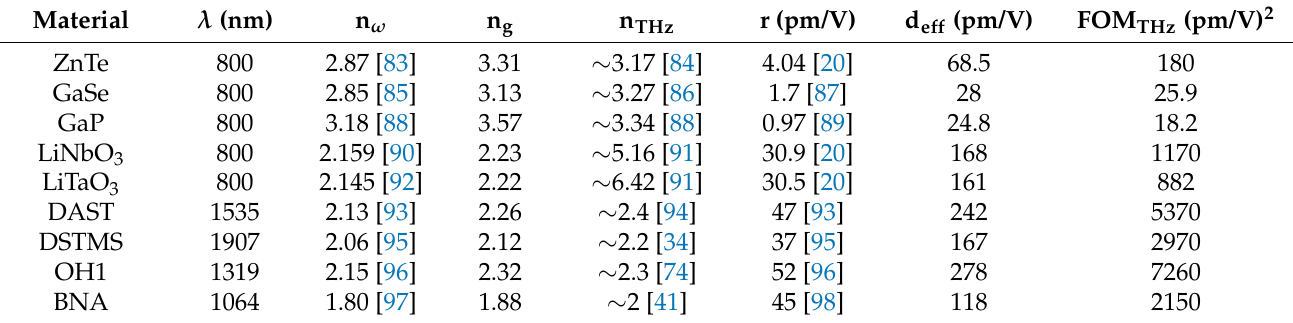
Table 1. Properties of some materials suitable for THz fsOR and DFG